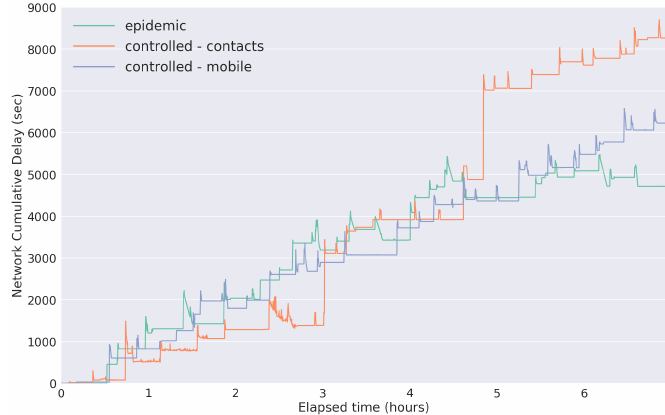
Figure 19. Cumulative network E2E delay